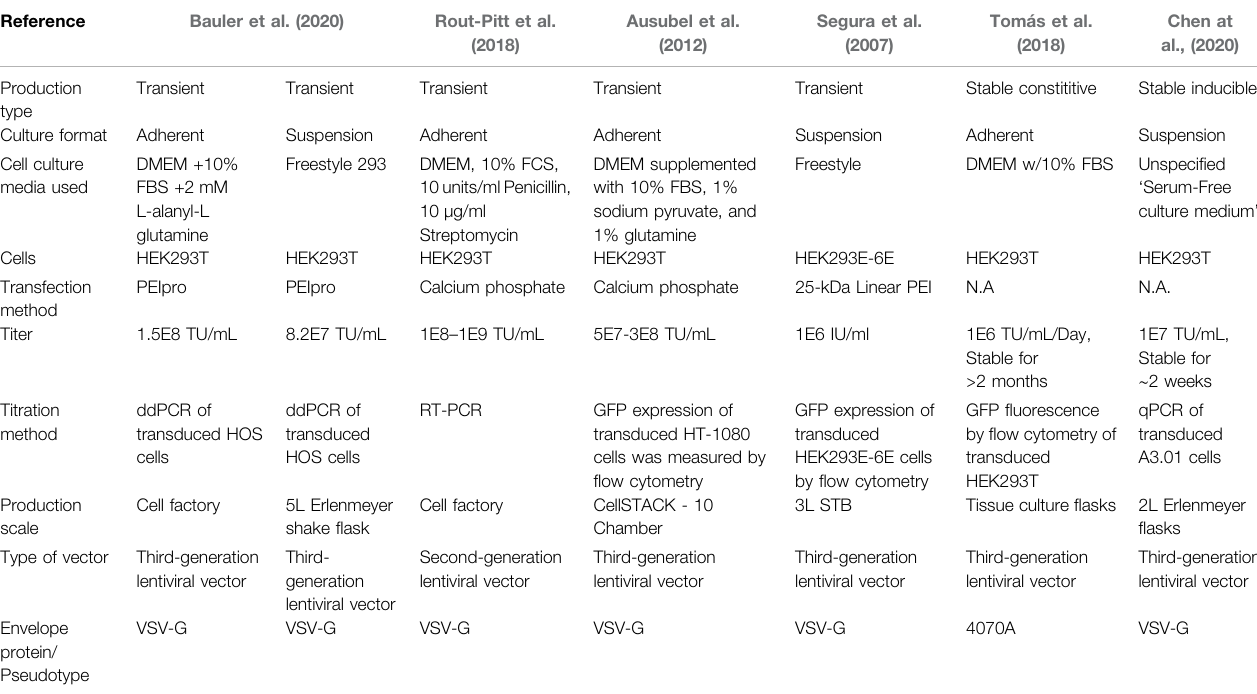
TABLE 3 | Comparison of various LV production